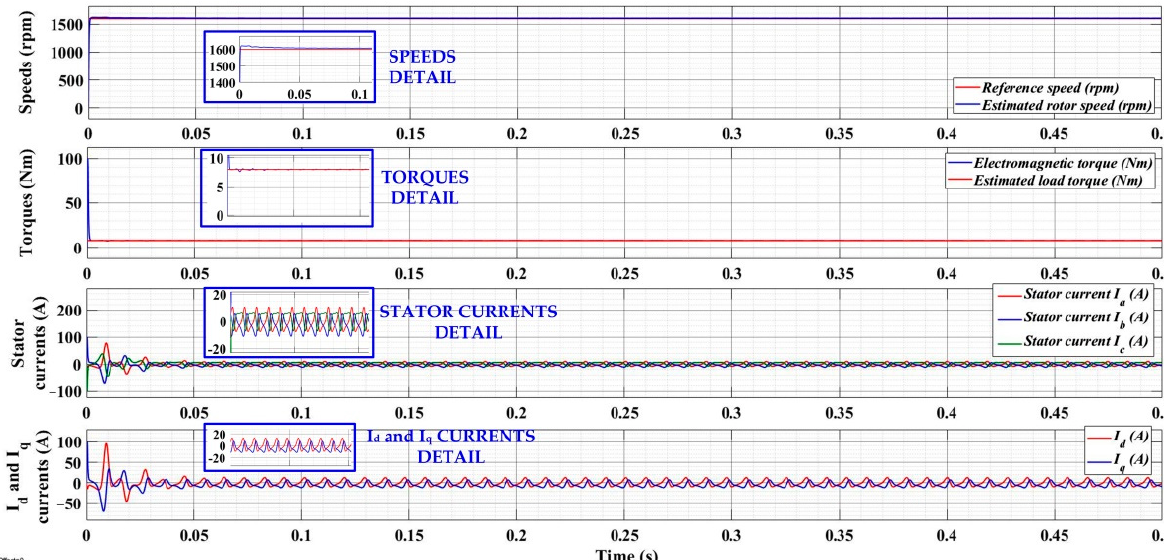
Figure 20. Time evolution for the numerical simulation of the PMSM control system based on the backstepping-PSO controller: ω ref = 3200 rpm, T L = 1 Nm, K ω = 0.01, K I ω = 140, K q = 5000, K Iq = 150, γ = 0.01, K d = 300, and K id = 300.